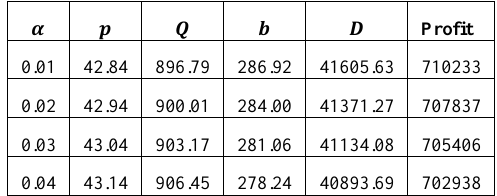
Table 1. Effect of changing the percentage of defectives on the selling price, optimal order level, backorder level, and retailer’s expected